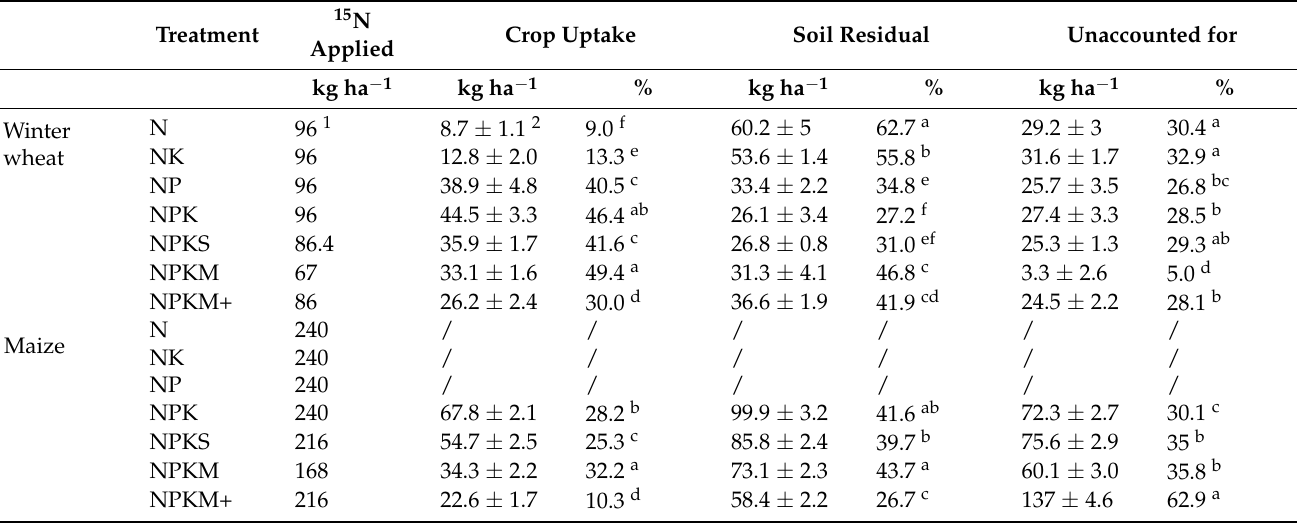
Table 4. The fate of fertilizer N in winter wheat in different long-term treatments using 15 N tracer method in